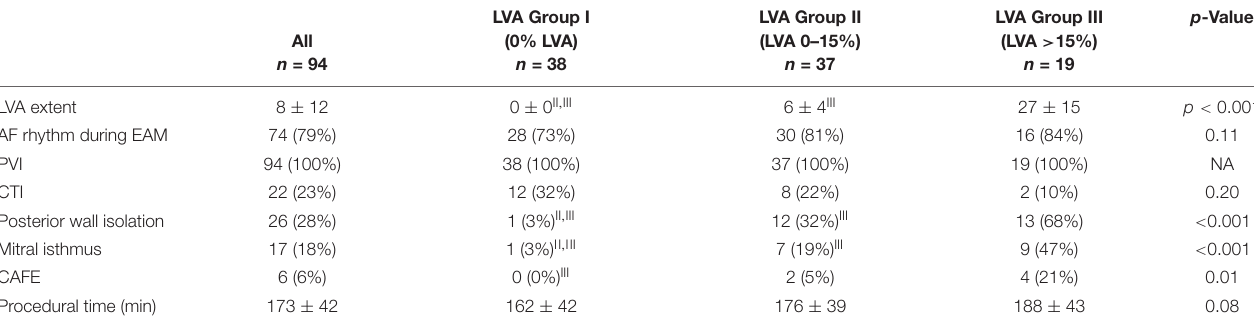
TABLE 2 | Procedural characteristics.